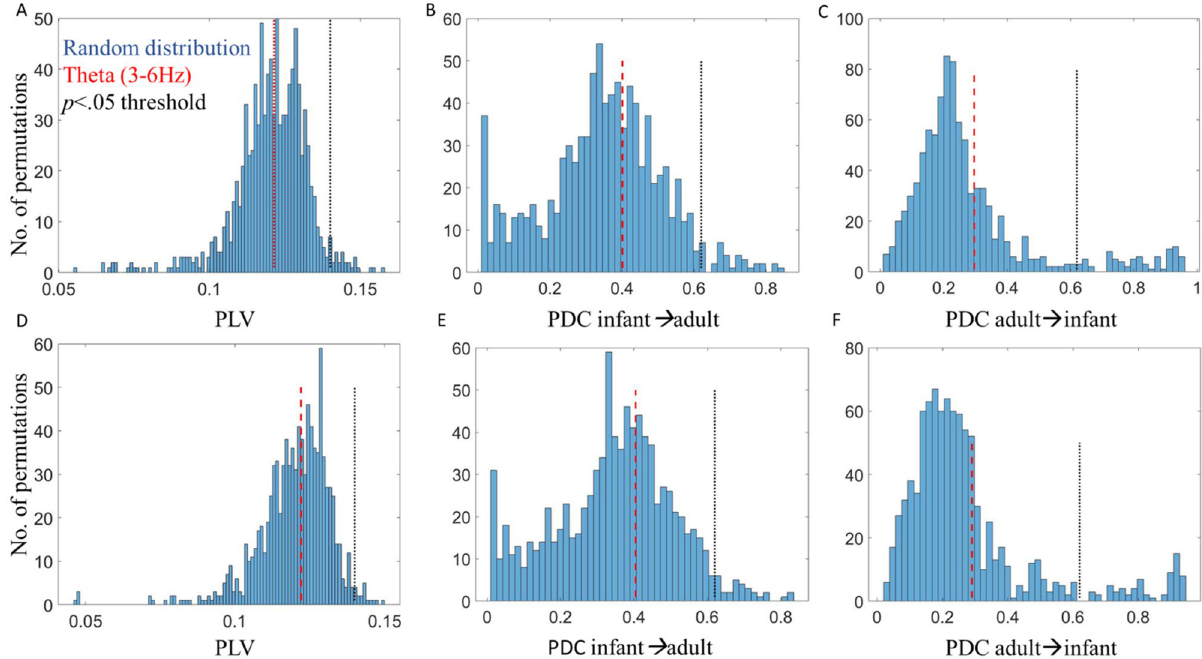
Figure 3. Results of permutation tests for non-event locked inter-brain synchrony analysis. ( A ) Distribution of random pair infant-adult PLV values compared to real pair infant-adult PLV values in Theta for mutual gaze. ( B ) Distribution of random pair infant → adult PDC values compared to real pair infant → adult PDC values in Theta for mutual gaze. ( C ) Distribution of random pair adult → infant PDC values compared to real pair adult → infant PDC values in Theta for mutual gaze. ( D ) Distribution of random pair infant-adult PLV values compared to real pair infant-adult PLV values in Theta for non-mutual gaze. ( E ) Distribution of random pair infant → adult PDC values compared to real pair infant → adult PDC values in Theta for non-mutual gaze. ( F ) Distribution of random pair infant → adult PDC values compared to real pair adult → infant PDC values in Theta for non-mutual gaze. Red dashed lines indicate averaged observed values in Theta, black dotted lines indicate the threshold for p <